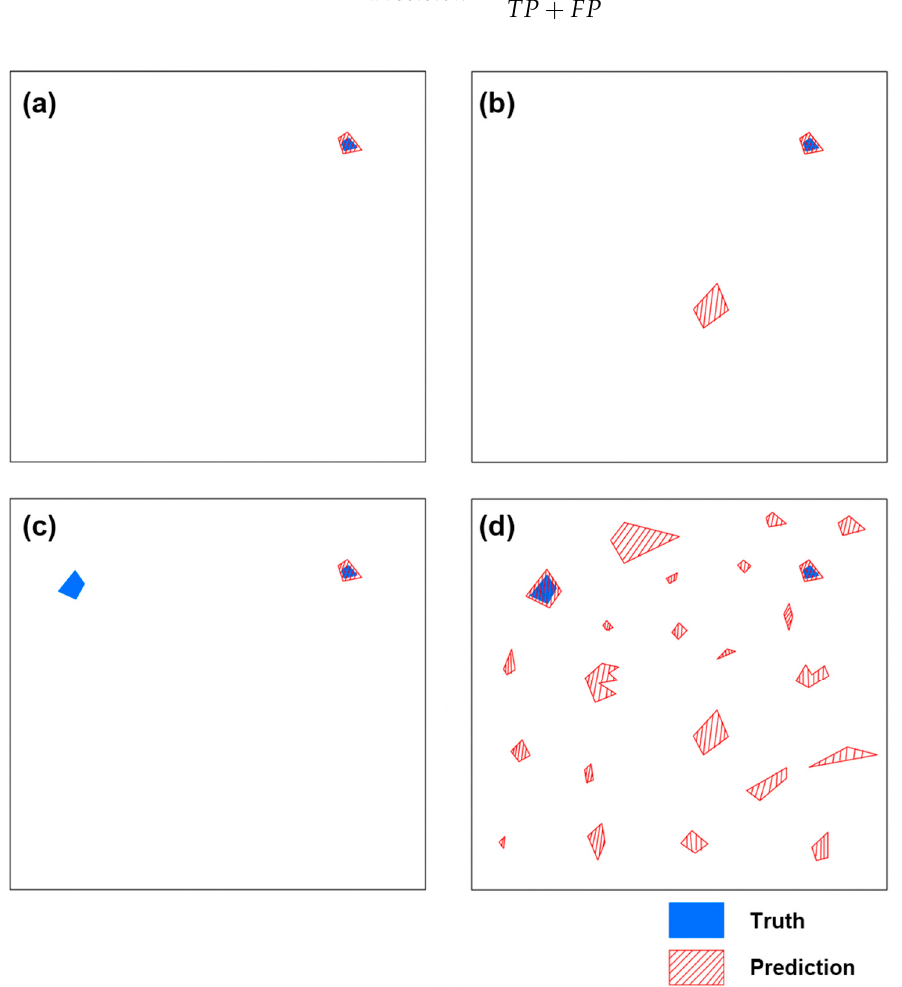
Figure 9. Hypothetical prediction result. ( a ) The best result. ( b ) The result showing insufficient precision. ( c ) The result showing insufficient recall. ( d ) The result showing excessively low precision.